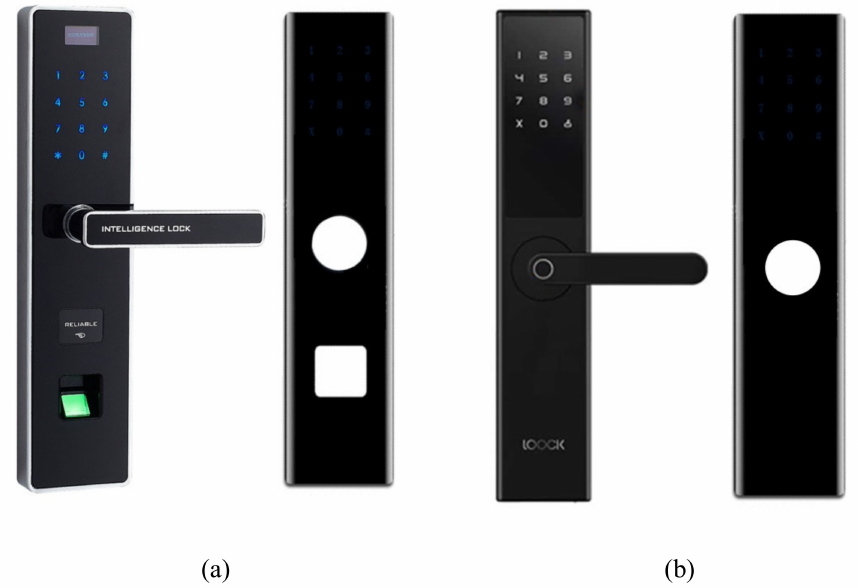
Figure 1. Glass fingerprint touch plate of different smart locks; ( a ) 3D fingerprint lock glass touch plate; ( b ) 3D code lock glass touch